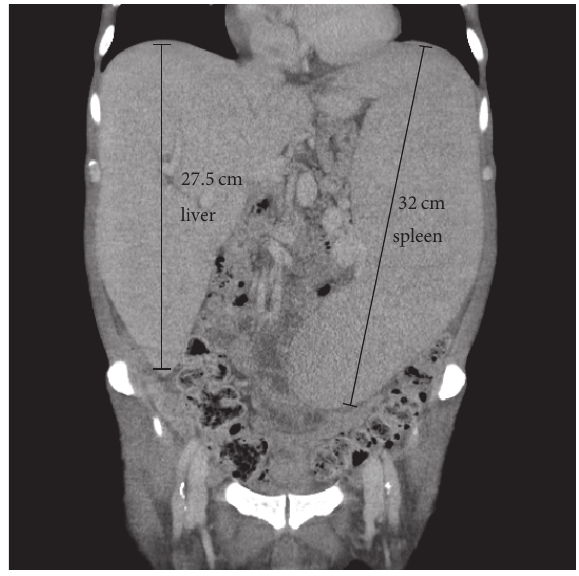
Figure 1: Preoperative CT demonstrating severe hepatospleno-